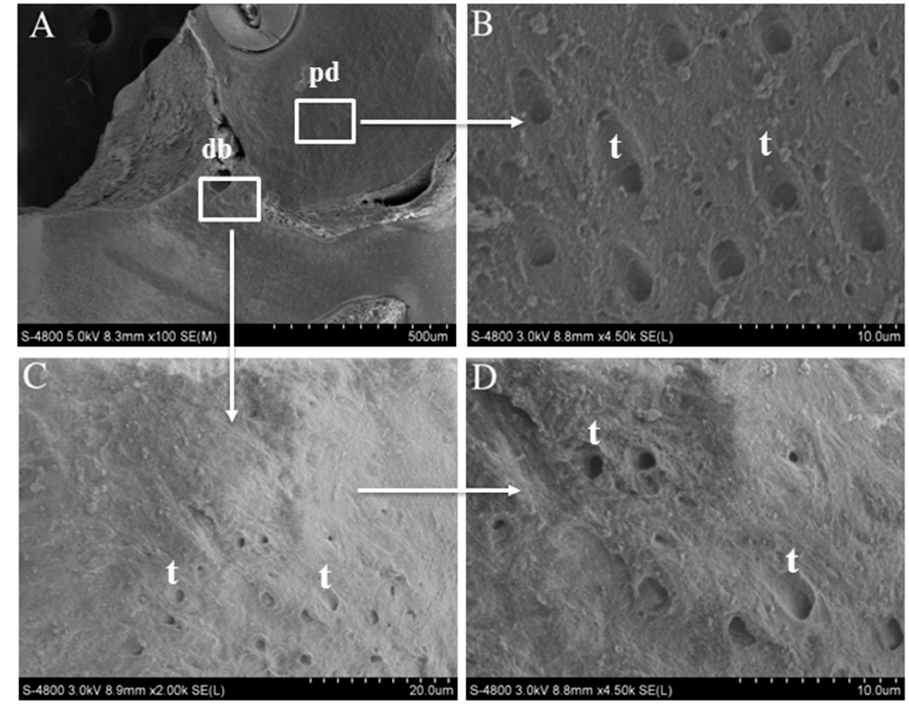
Figure 3. Scanning electron micrograph after direct pulp capping using MTA. SEM analysis shows a well-mineralized tissue near the pulp exposure ( A ) and at higher magnification, many dentinal tubules through the reparative dentin bridge can be observed ( C , D ). The number of dentinal tubules is lower than that of the primary dentin ( B